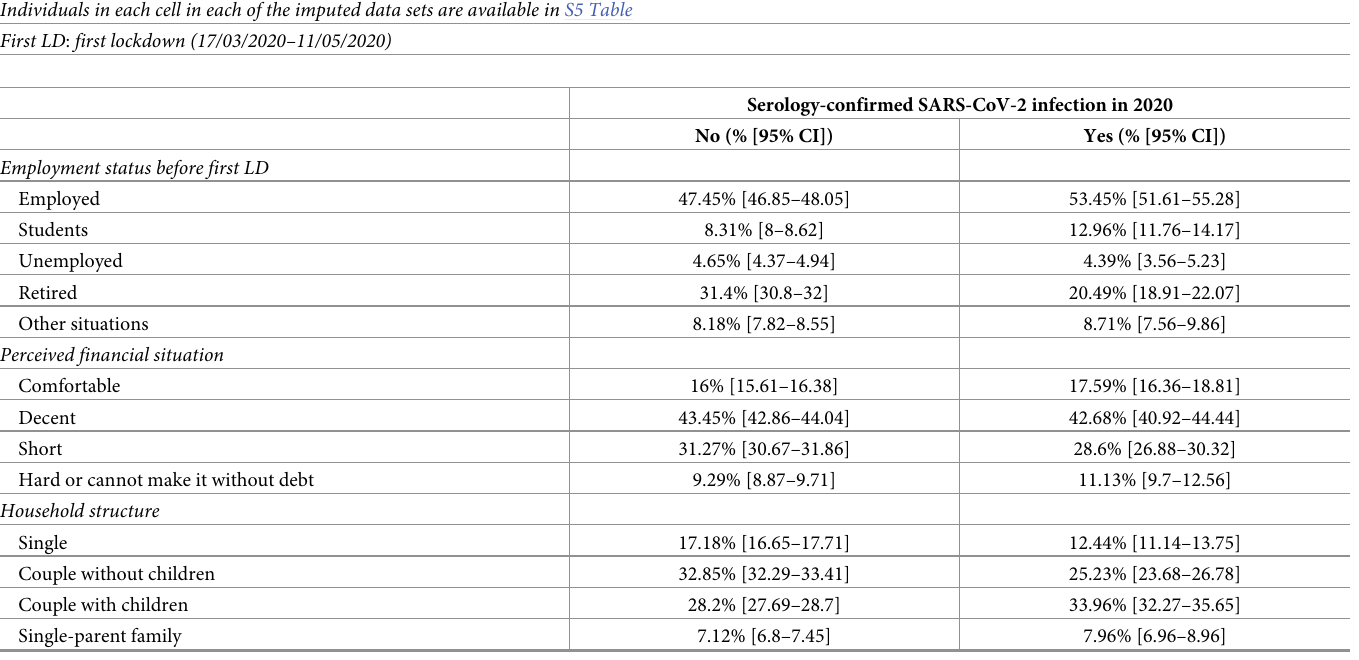
Serology-confirmed SARS-CoV-2 infection in